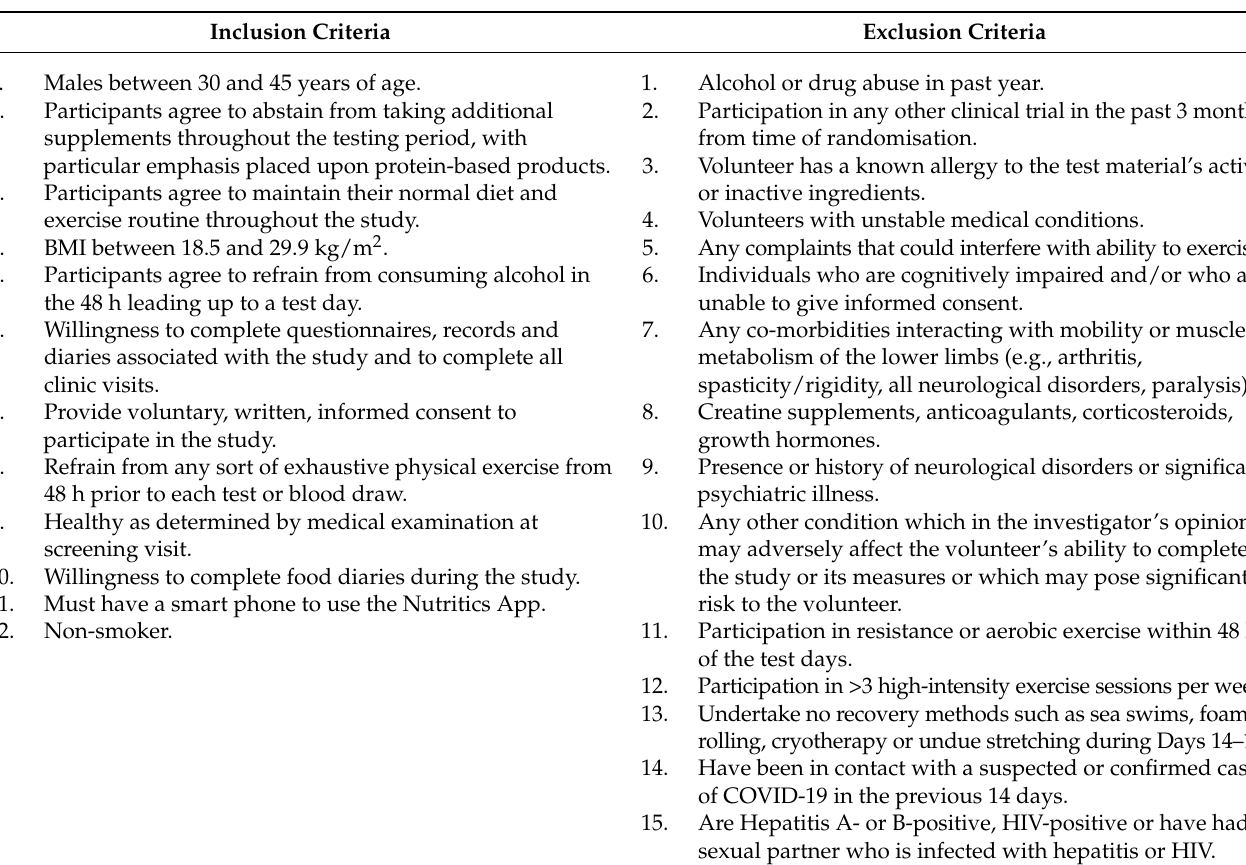
Table 1. Subject inclusion and exclusion